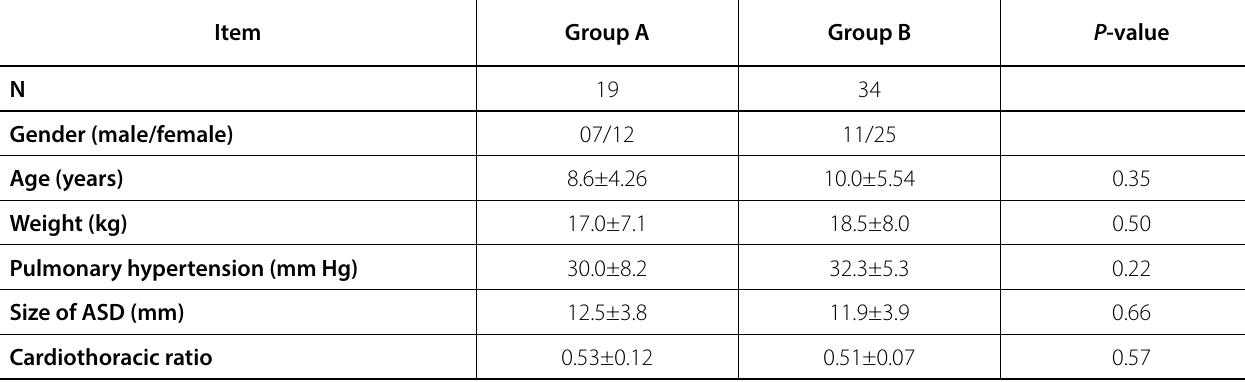
Table 1 . Preoperative data comparison between two groups of patients.